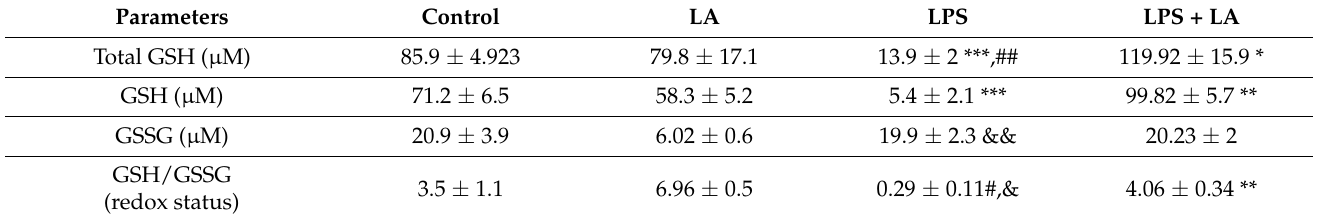
Table 3. Atria status of glutathione metabolism in the control, LA, LPS, and LPS + LA groups. Parameters